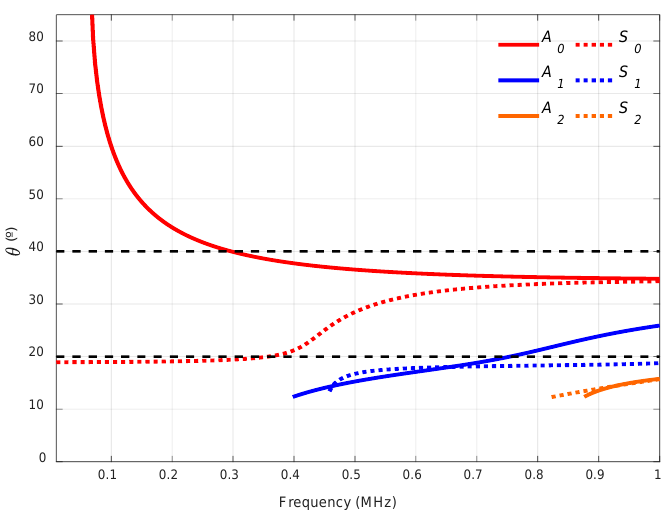
Figure 17. Incidence angle dispersion curves for a mortar plate and water as the coupling medium ( c = 1490 m / s). The chosen angles (20 ◦ , 40 ◦ ) are represented by black discontinuous curves.